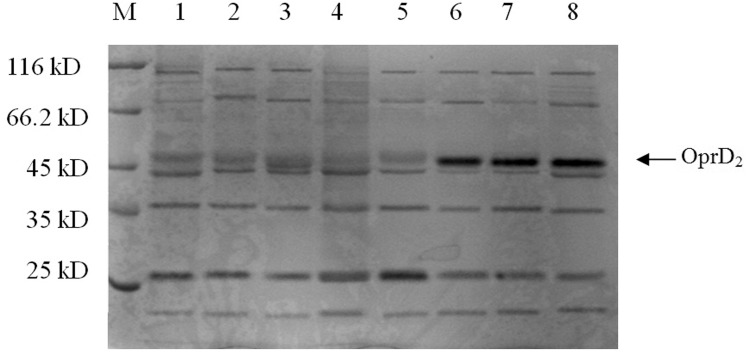
SDS-PAGE for the OprD2 protein in Pseudomonas aeruginosa strains.M = standard marker protein, lane 1–3 = IMPRMEMR strains, lane 4–5 = IMPRMEMS strains, lane 6 = IMPSMEMR strains, lane 7 = for IMPSMEMS strains, 8 = PAO1. The expected band size of 46 kDa was detected for the OprD2 protein in the two IMPS strains and the PAO1 strain (6–8), while the size decreased in the IMPR strains 1–5.